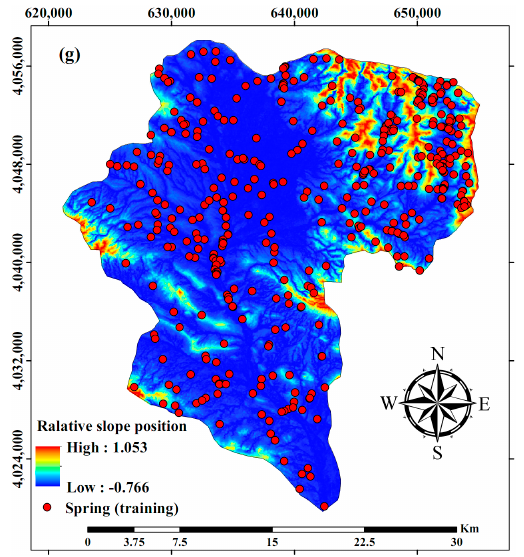
Figure 3. Topographical driving factors of Hesare-No Basin including: ( a ) altitude, ( b ) slope degree, ( c ) aspect, ( d ) slope length, ( e ) plan curvature, ( f ) profile curvature, and ( g ) relative slope position.